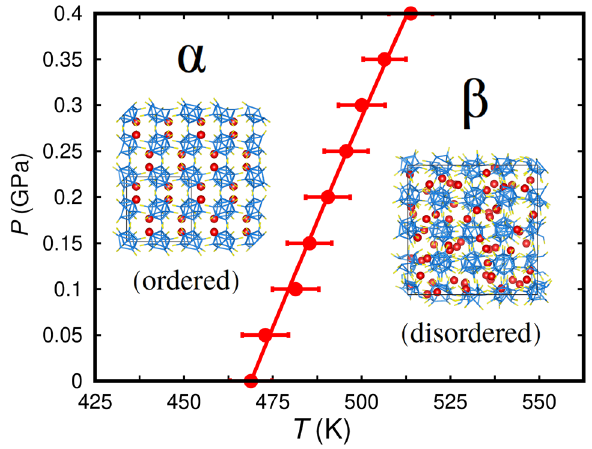
Figure 2. Estimated Li 2 B 12 H 12 phase diagram expressed as a function of pressure ( P ) and temperature ( T ). Results were obtained from classical molecular dynamics simulations performed with the LBH force field reported in work 38 . The coexistence line separating the stability region of the α and β phases, represented with a solid red line, was determined through a polynomial fit to the theoretical phase-transition data (solid red dots and error bars) and corresponds to the analytical expression T α ↔ β ( P ) = 468.98 + 103.96 · P + 13.97 · P where the temperature and pressure are respectively expressed in units of K and GPa. Error bars represent statistical uncertainties estimated with time-average techniques (“Methods”).